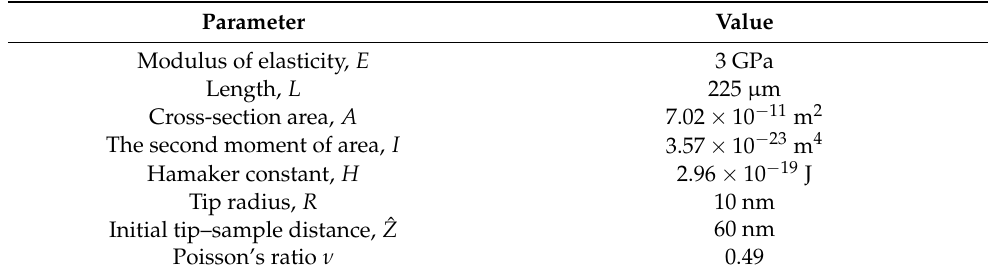
Table 1. The material and geometrical parameters of the AFM